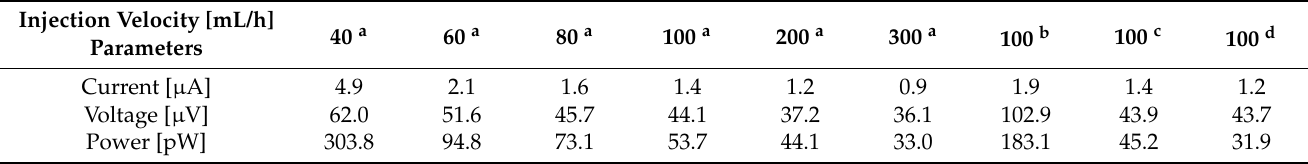
Table 4. The corresponding parameters for current, voltage, and power outputs produced by dropping simulated raindrops onto graphene electrode. Reproduced with permission from [37] Copyright © 2021, Royal Society of